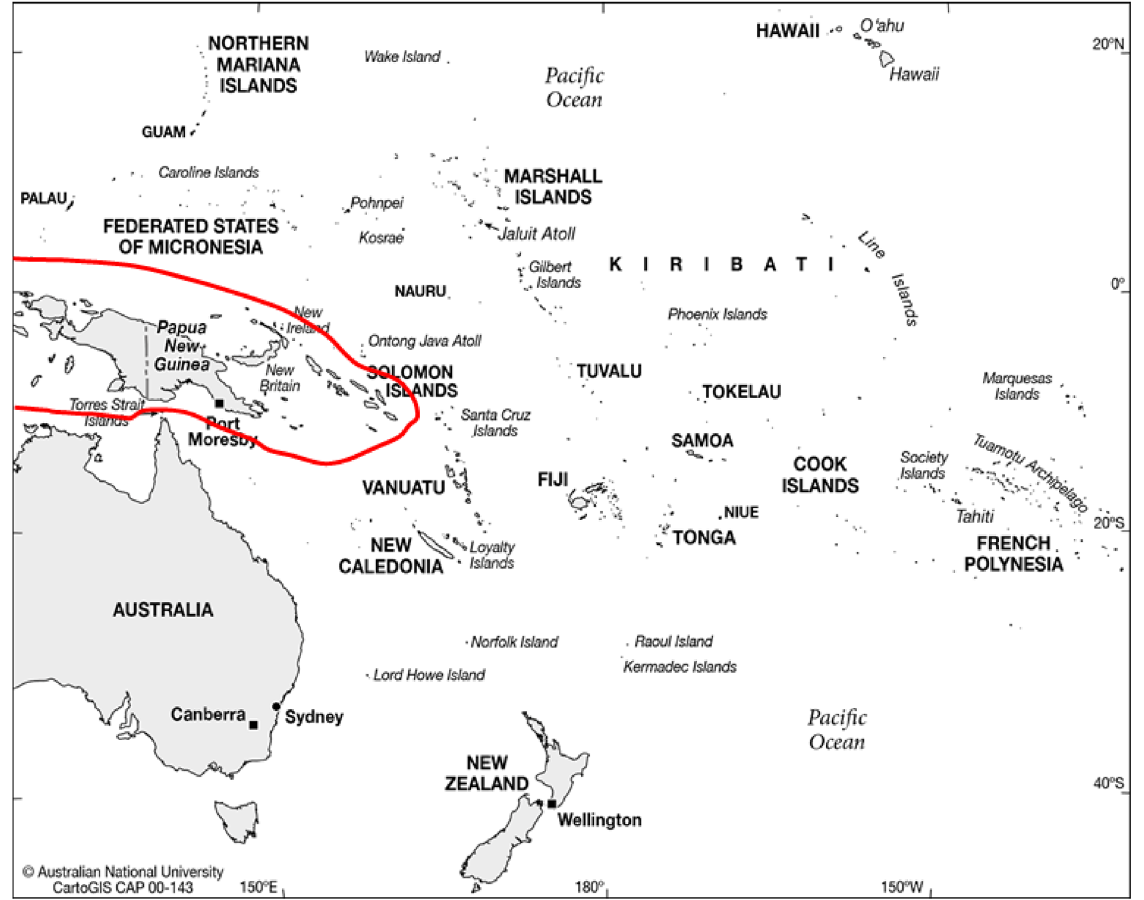
Fig. 17. Regional distribution of the genus Popowia (Annonaceae) in the Pacific. Base map sourced from CartoGIS, College of Asia and the Pacific, The Australian National University,